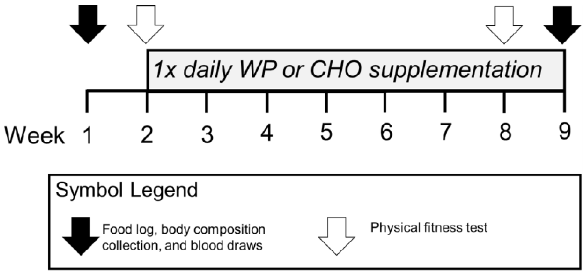
Figure 2. Timeline for outcome measures and interventions for this nine-week study.